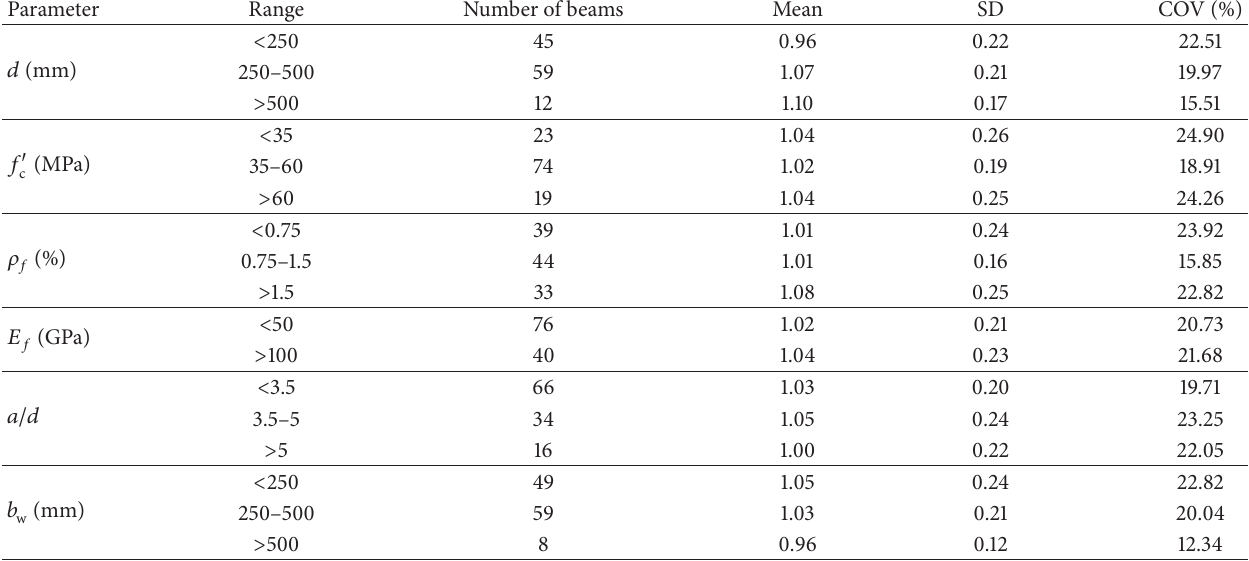
Table 5: Range of parameters and statistical comparison of experimental